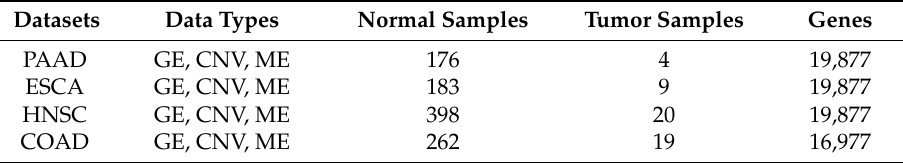
Table 1. Description of four multi-view